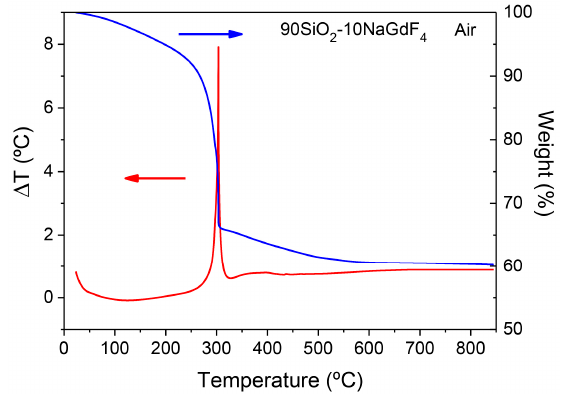
Figure 14. DTA (red) and TG (blue) curve of 90SiO 2 -10NaGdF 4 bulk sample acquired in air using a heating rate of 10 °C/min.